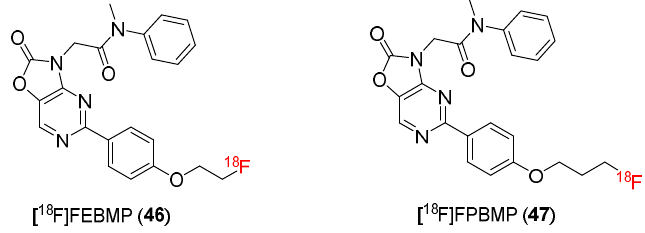
Figure 6. Structures of TSPO ligands containing acetamidobenzoxazolone. In 2014, 2-[5-(4-[ 18 F]fluoroethoxyphenyl)-([ 18 F]FEBMP)and2-[5-(4-[ 18 F]fluoropropyloxyphenyl)-([ 18 F]FPBMP) -2-oxo-1,3-benzoxazol-3(2H)-yl]-N-methyl-N-phenylacetamide were reported by Zhang and co-workers [103]. [ 18 F] FEBMP ( 46 ) and [ 18 F]FPBMP ( 47 ) were both synthesized from 2-nitro-4-bromophenol ( 48 ). During the six-step procedure, 2-nitro-4-bromophenol ( 48 ) was converted to 2-[5-(4-Hydroxyphenyl)-2-oxo-1,3-benzoxazol-3(2H)-yl]-N-methyl-N-phenylacetamide ( 49 ), which reacted with 1-bromo-2-[ 18 F]fluoroethane or 1-bromo-3-[ 18 F]fluoropropane to yield [ 18 F]FEBMP ( 46 ) and [ 18 F]FPBMP ( 47 ) (Scheme 14). The radiochemical yields of [ 18 F]FEBMP and [ 18 F]FPBMP were 22 ± 4% ( n = 8) and 5 ± 2% ( n = 5), respectively. The radiochemical purities for [ 18 F]FEBMP and [ 18 F]FPBMP were both found to be 98%, and the specific activity ranged from 98 to 364 GBq/mol.